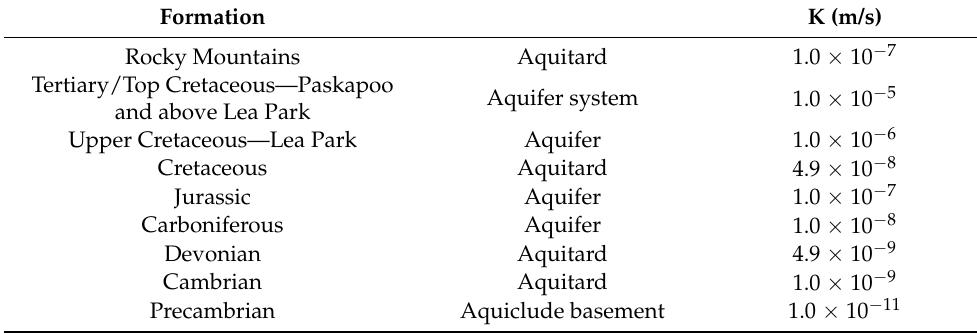
Table 1. Typical hydraulic conductivities in the study